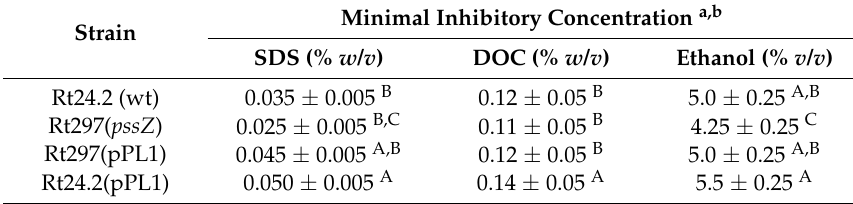
Table 2. Sensitivity of the wild-type R. leguminosarum Rt24.2 and its derivatives to various stress factors.